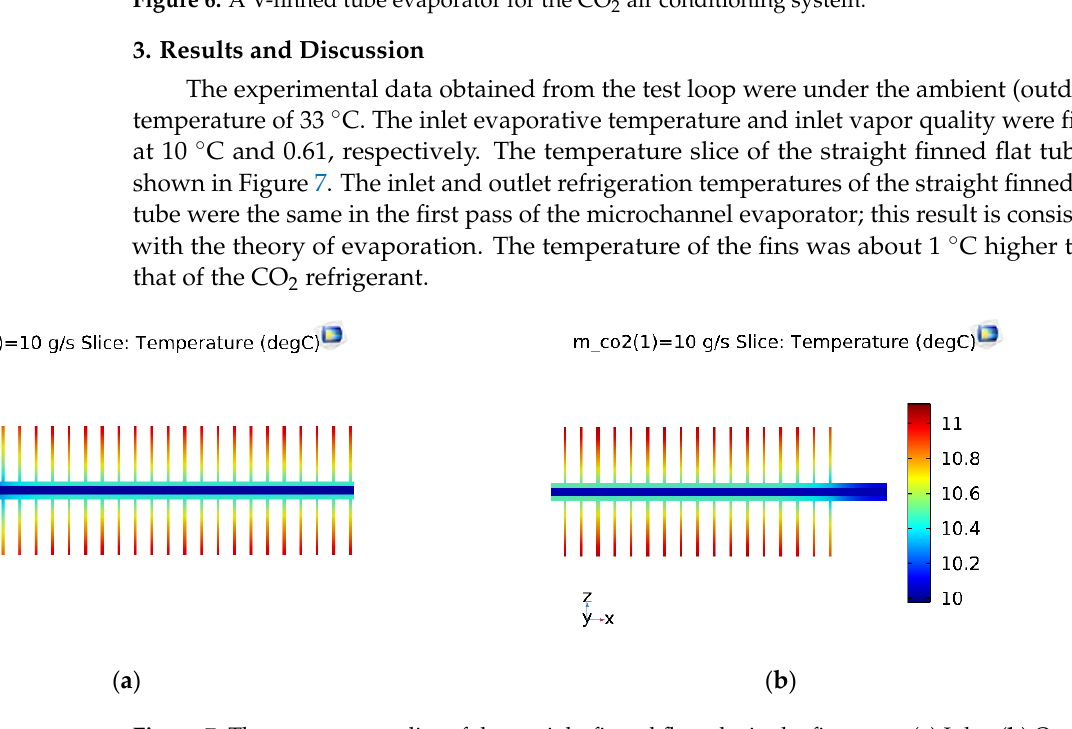
Figure 7. The temperature slice of the straight finned flat tube in the first pass. ( a ) Inlet; ( b ) Outlet.